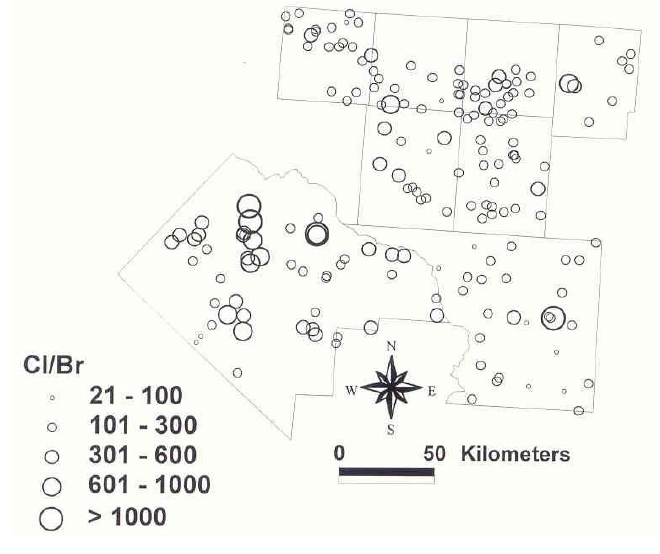
FIGURE 3. Map of chloride/bromide ratios (excluding undefined ratios in Table